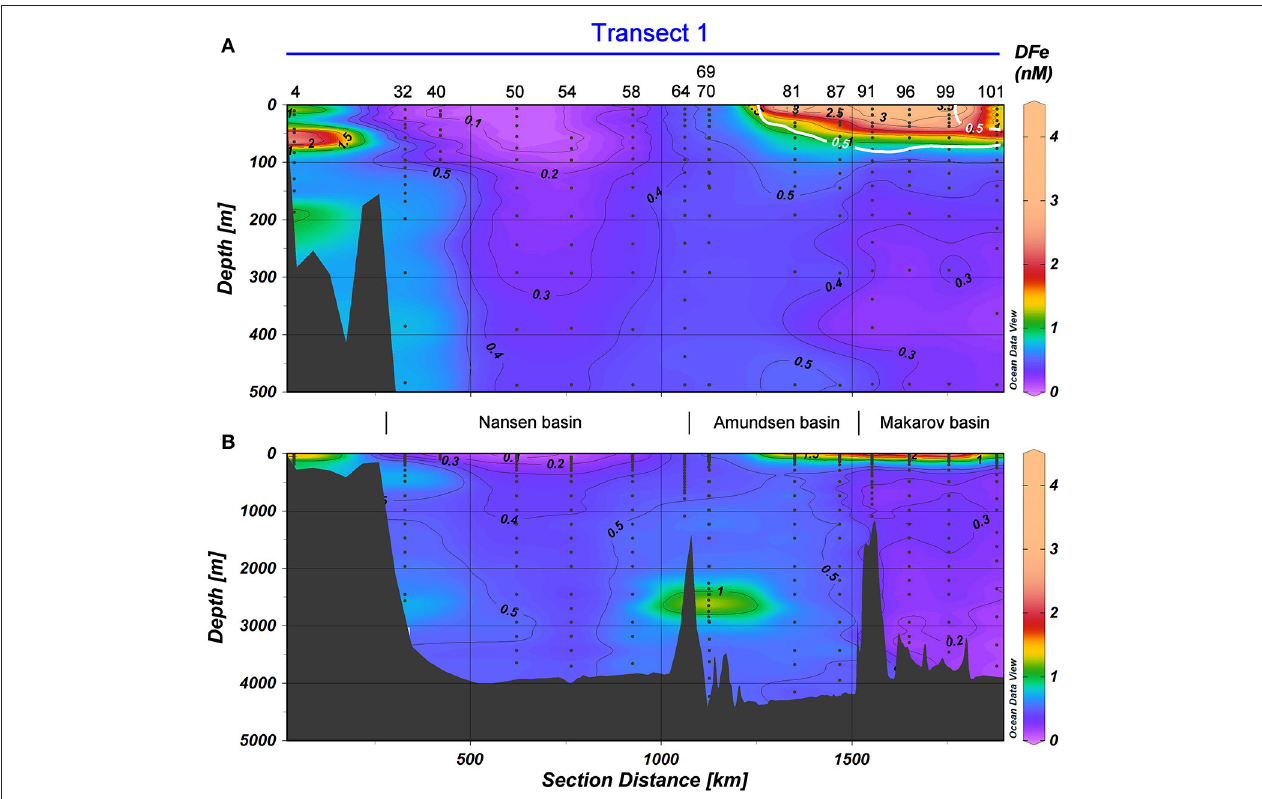
FIGURE 5 | DFe in nM in Transect 1, with (A) the top 500m and (B) the full depth. Station numbers and basin names are given (see Figure 1 ). The white contours indicate the border of the TransPolar Drift as defined by Slagter et al. (2017), which was operationally defined as in-situ CDOM fluorescence ≥ 0.5a.u. during the same cruise. Black contours indicate DFe and have an equidistance of 0.1nM for the range 0 ≤ DFe ≤ 0.5nM and of 0.5nM for the range 0.5 < DFe ≤ 4.5nM.